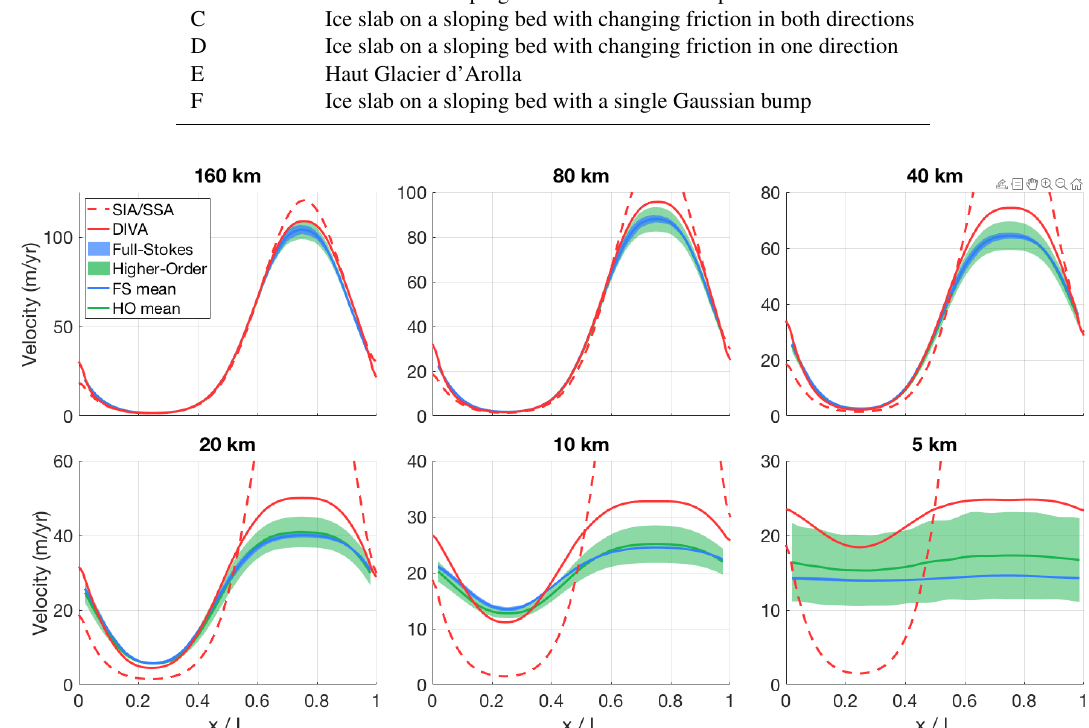
Figure 6. Modelled surface velocity transects for all versions of ISMIP-HOM experiment A, calculated with both the old hybrid SIA/SSA solver (dashed red line) and the new DIVA solver (solid red line). The results of the higher-order models (green) and the full-Stokes models (blue) that participated in ISMIP-HOM are shown for